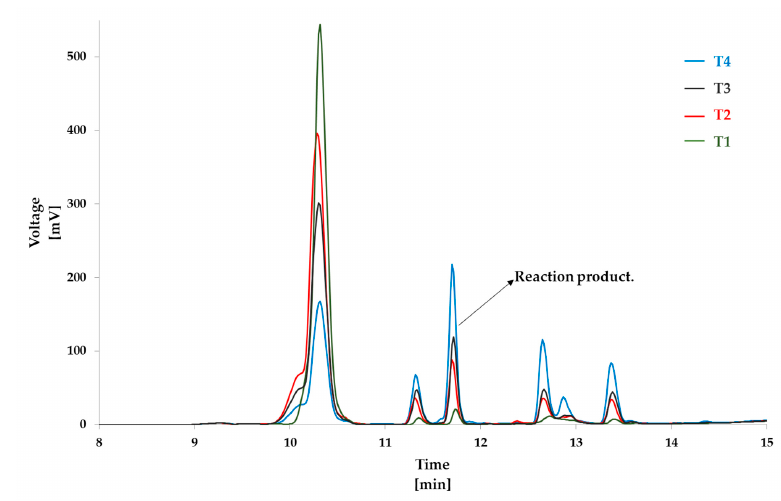
Figure 6. Overlaid chromatograms of N α -benzoylglycyl- L -lysine and derivatives in blank samples after different times of incubation at 180 °C (T1: 5 min, T2: 10 min, T3: 30 min, and T4: 60 min).